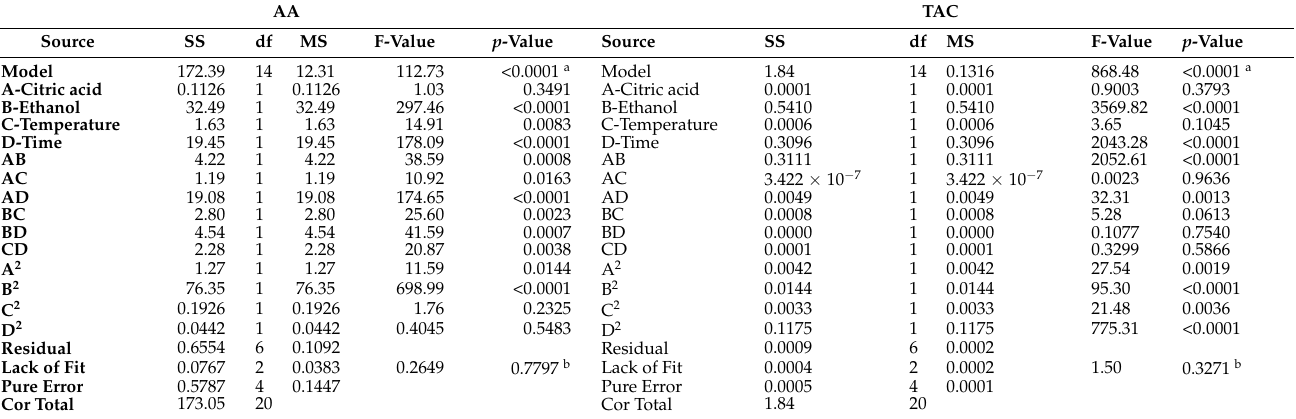
Table 3. ANOVA for the reduced quadratic model for AA and